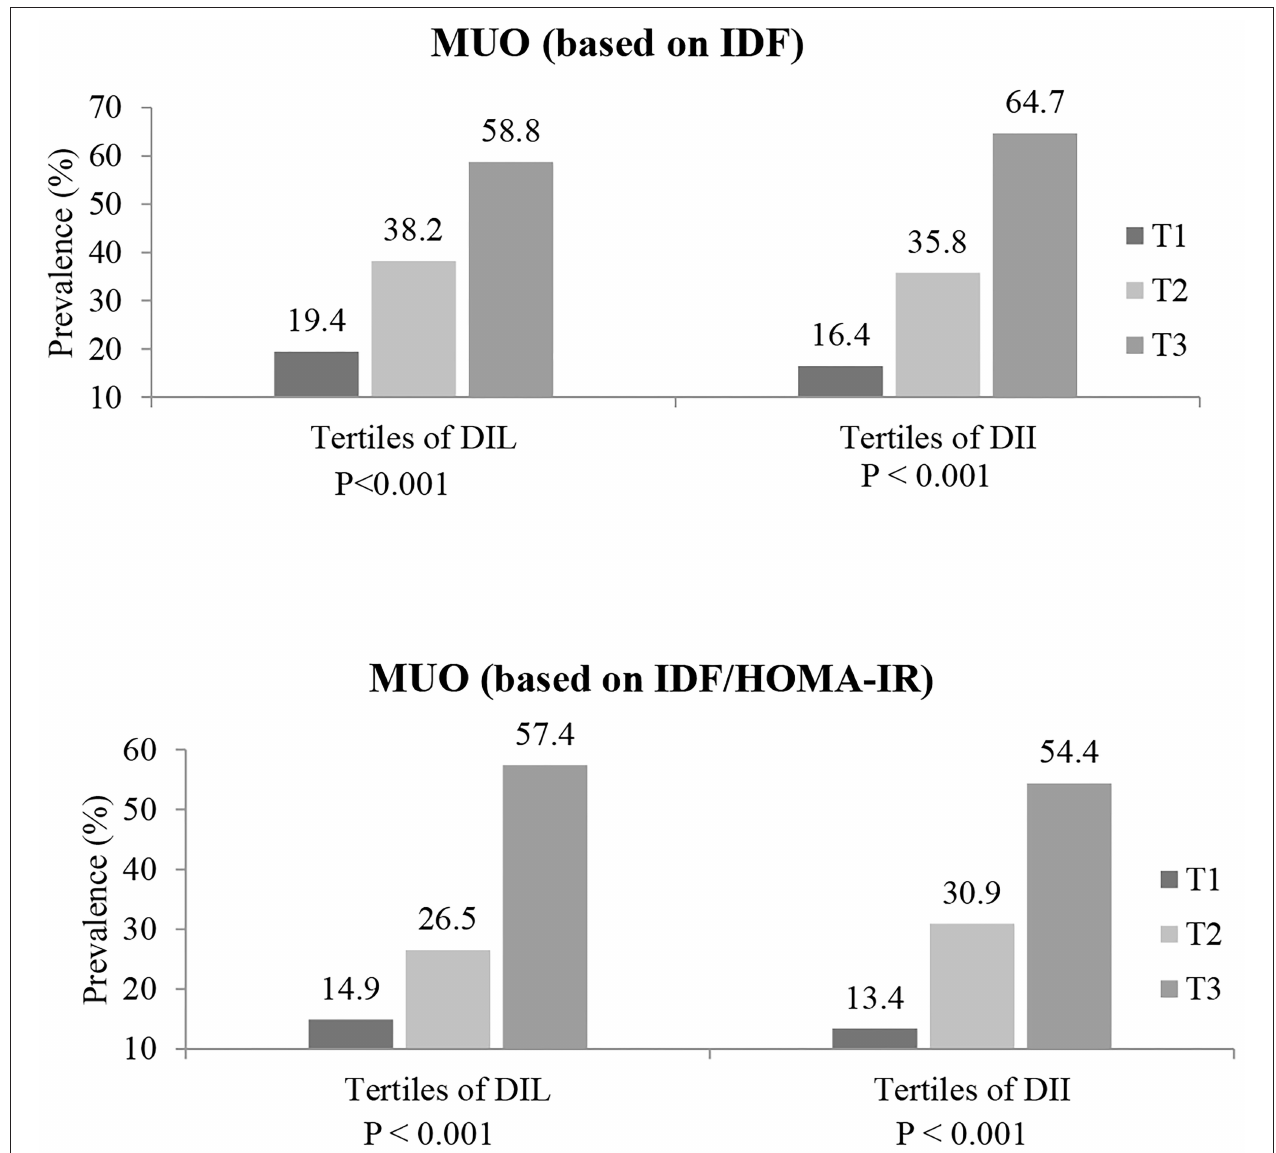
FIGURE 1 | Prevalence of MUO (based on both IDF and IDF/HOMA-IR definitions) in tertiles of DIL and DII.